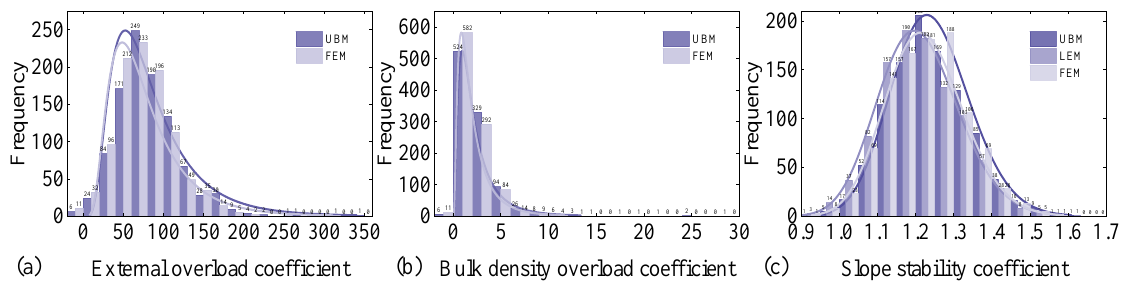
Figure 4. Relationship between bulk density and slope stability coefficient of homogeneous slope.